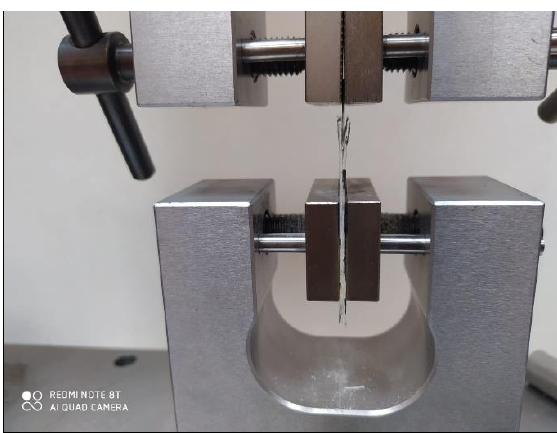
Figure 7. Shear test equipment.